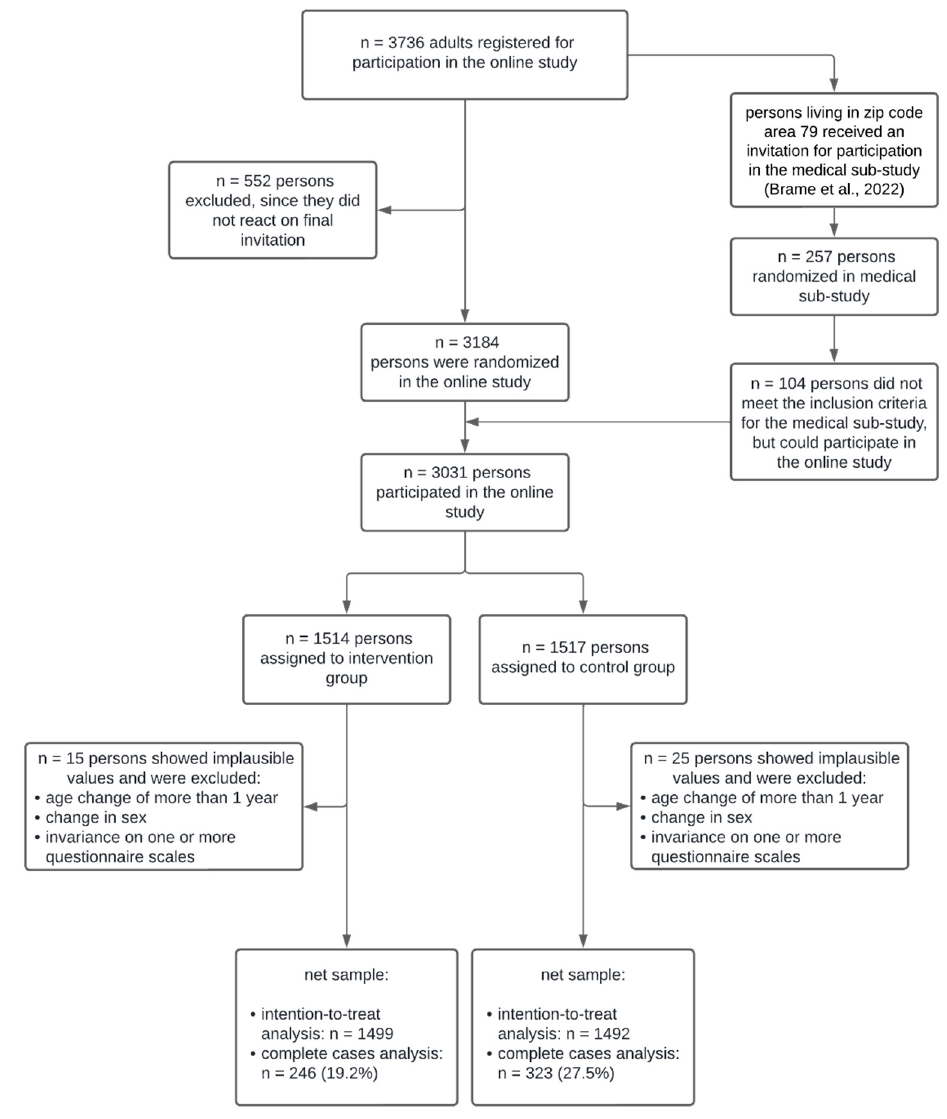
Figure 1. Participant flow in the WLC [42]. The sample showed high dropout rates with about 65% missing values in the IG and about 55% missing values in the CG at each time point after baseline. At baseline, only 5% missings occurred in each group. A total of 57% of the participants with missing values in the IG (respectively 40% in CG) dropped out for all time points after baseline measurement (considered as real dropouts). About 25% of the participants in the IG (and 32% in the CG) had missing values for only one or two measurement time points after